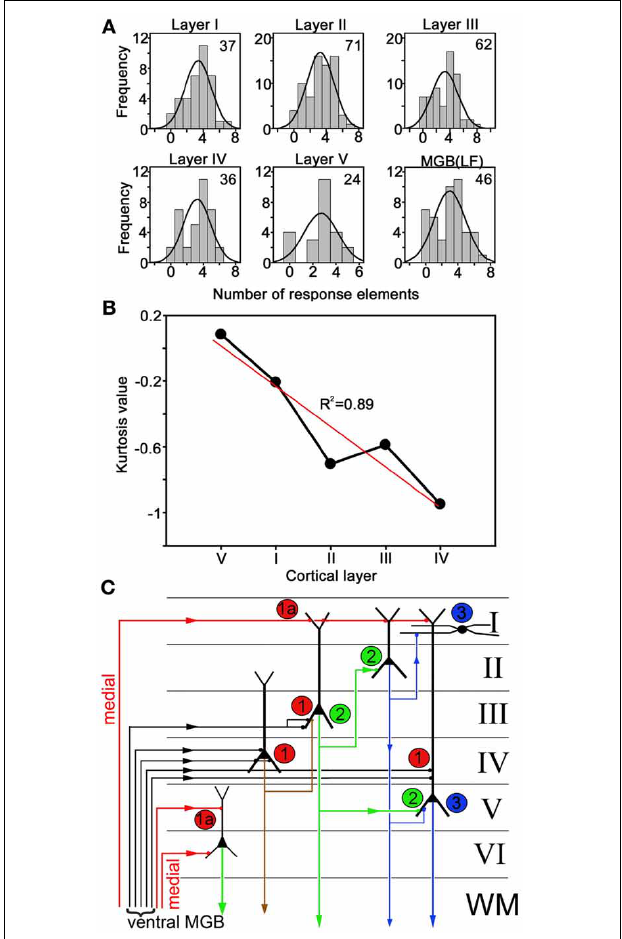
FIGURE 12 | (A) Units were assigned to a cortical layer based on their depth and the number of units responding to a given number of call elements was plotted as a histogram and compared to a normal distribution. The relatively small number of units recorded from each layer (number in upper right hand corner of each panel) meant that the distributions were not perfectly normal, but it was possible to calculate a value for how flat the distributions were (kurtosis). (B) Plot of kurtosis values for the distributions of response frequency to a particular number of call elements versus the cortical layer. When the layers were arranged in functional distance from layer IV there was a linear relationship. The regression line (red) had an R 2 value of 0.89. (C) Simplified diagram showing some of the main excitatory connections in the auditory cortex. The main thalamic inputs from the ventral MGB are thought to terminate on a variety of cells in layer IV and the base of layer III (labeled 1) whereas the inputs from the medial MGB (labeled 1A) mainly terminate in layers I, V, and VI. Layer IV pyramidal cells project into layer III whereas layer III pyramidal cells project to layers II and V (labeled 2). Layer II pyramidal cells project to layer I and layer V (labeled